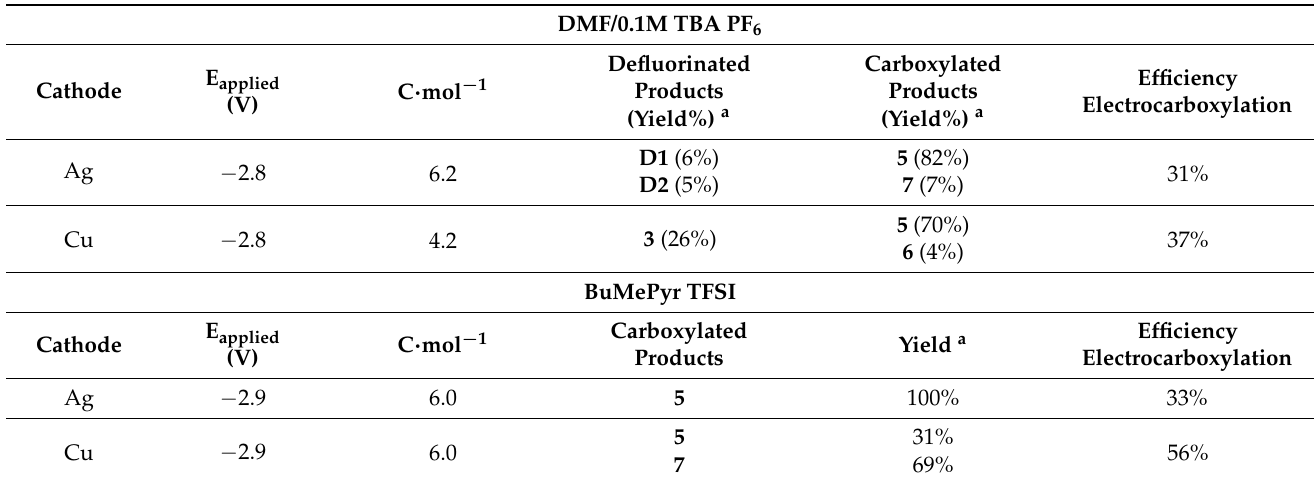
Table 5. Products obtained after the electrochemical carboxylation of 1 in both electrolytic medias with three different cathode